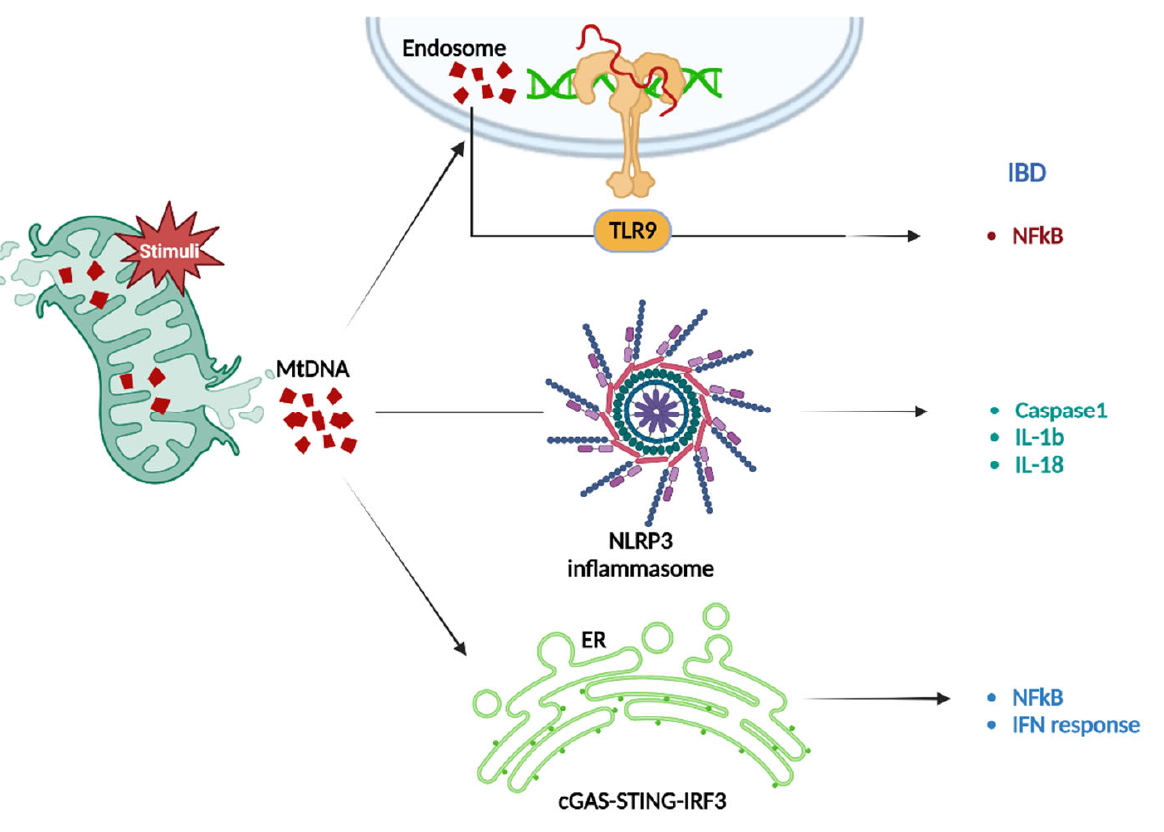
Figure 4. mtDNA mediated IBD through different pathways.